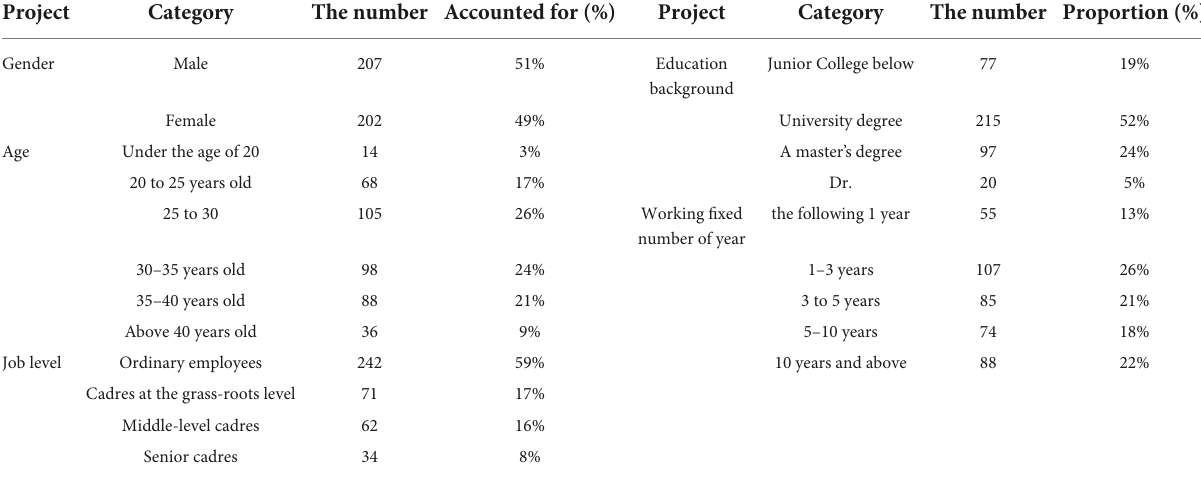
TABLE 1 Basic information of